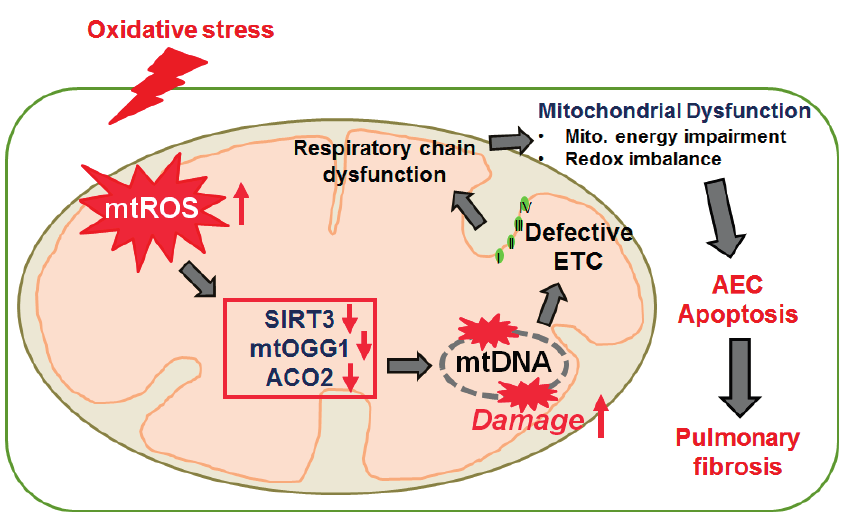
Figure 2. Proposed model of mtDNA damage in mediating AEC intrinsic apoptosis and pulmonary fibrosis. Oxidative stress-induced mtROS induces mtDNA damage by decreasing SIRT3, ACo-2 and mtOGG1 in AEC. MtDNA damage causes a defective ETC that can promote mitochondrial dysfunction, AEC apoptosis, and pulmonary fibrosis. I, II, III, IV, four different complex of ETC in mitochondria. Red-up arrow, increase; red-down arrow,